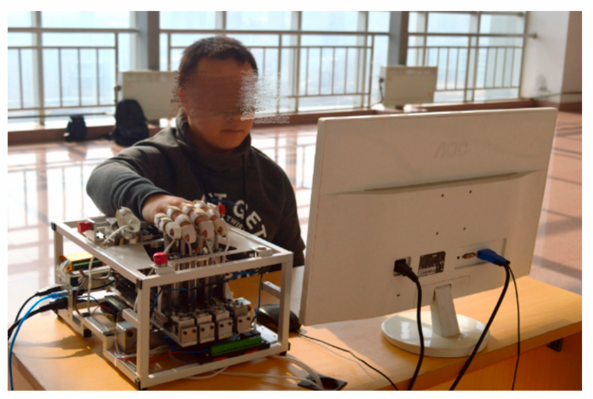
Figure 1. Prototype of the EFRR. EFRR: end-effector finger rehabilitation